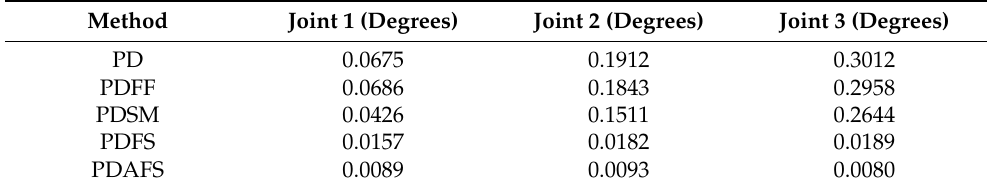
Table 7. RMSE Comparison among the controllers and PDAFS in the Parabolic